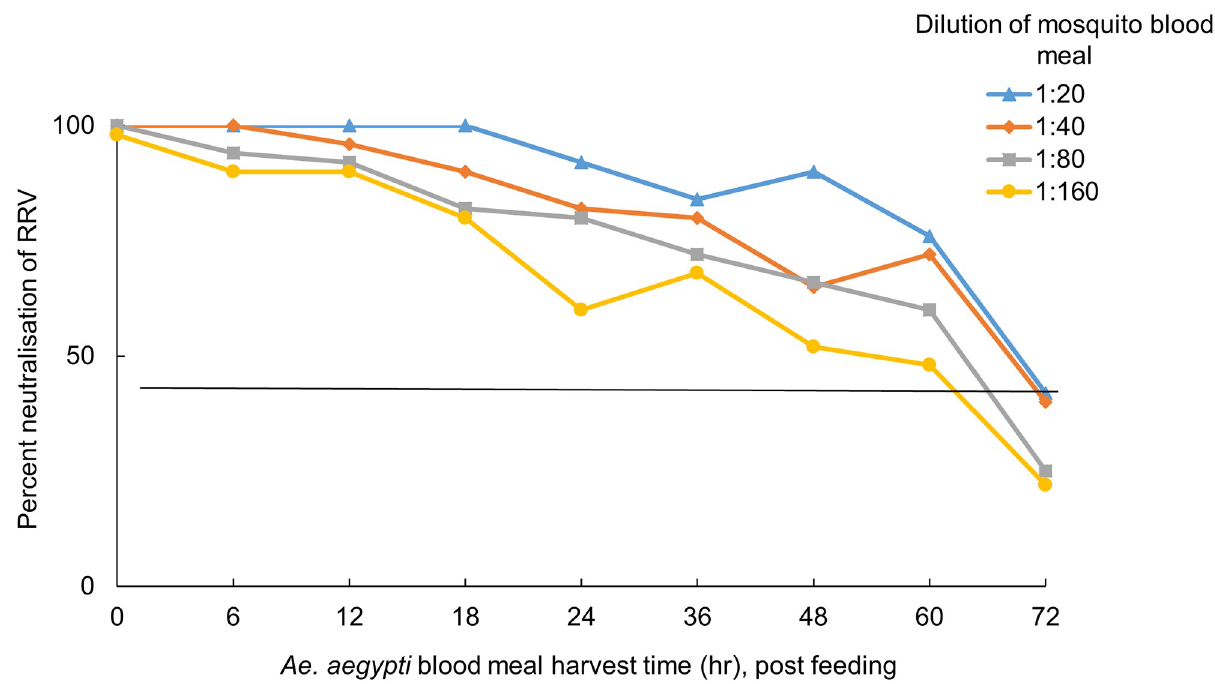
Fig 4. Percent neutralisation of RRV by vertebrate antibodies in mosquito blood meals harvested at different time points post blood-feeding. Blood meals obtained from RRV positive sera and harvested at different times post-feeding were diluted at four different concentrations and tested in duplicate. Antibodies continued to neutralise � 50% of plaques at all dilutions, until 60 hr post feeding.